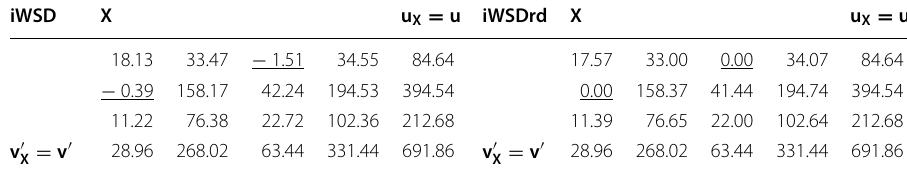
With the same location of underlined matrix elements as in Table 6